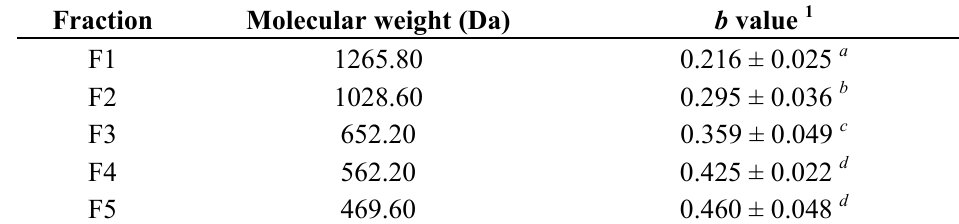
Table 5. Protein-binding affinities of CT fractions of different molecular weights using bovine serum albumin (BSA) as reference